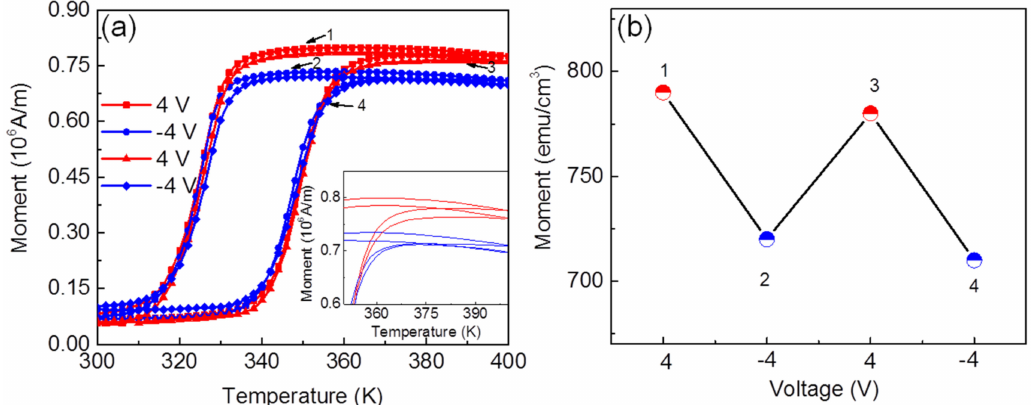
Figure 3. ( a ) Temperature-dependent magnetization with applied voltages of 4 and − 4 V for FeRh thin films. The inset shows the enlarged figure of the temperature-dependent magnetization. ( b ) Voltage dependence of saturated magnetization measured with a magnetic field of 2 kOe in FeRh thin